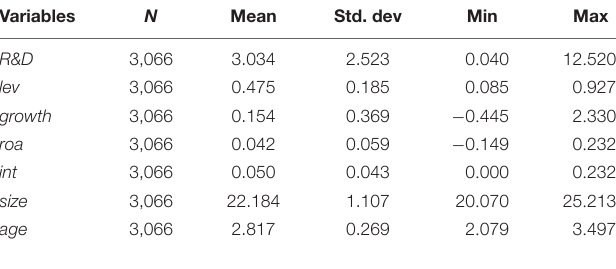
TABLE 3 | Descriptive statistics of